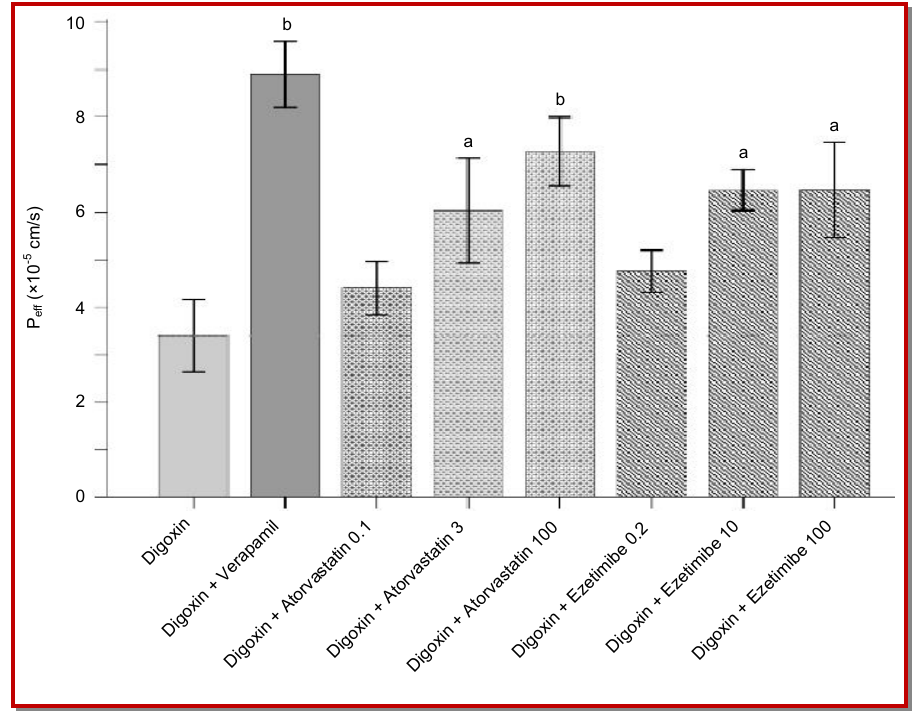
Figure 5: Effects of different concentrations of atorvastatin (0.1, 3 and 100 µM), ezetimibe (0.2, 10 and 100 µM) and verapamil (P-gp inhibition control) on the effective permeability (P eff ) of digoxin compared to the control group (digoxin) (n = 3). Bars show mean ± SD. a and b represent significantly different from control (digoxin) group (p<0.05 and p<0.01